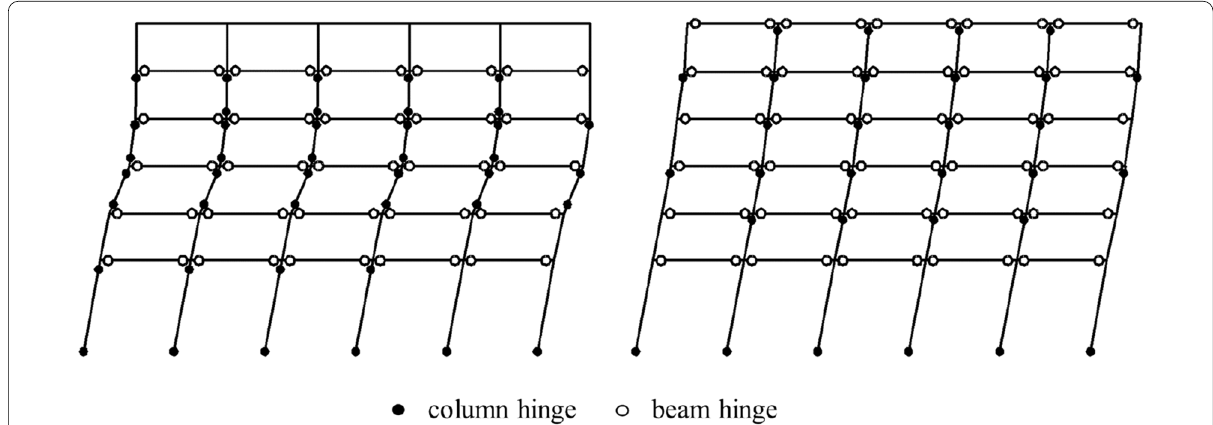
Fig. 6 Typical collapse mechanisms observed during seismic